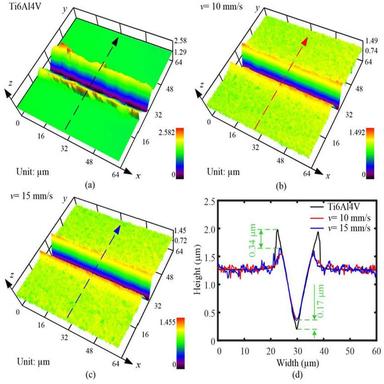
3D topographies of the residual scratches obtained on (a) the Ti6Al4V surface and the surfaces with nanoporous structures obtained under different laser scanning speeds (P = 1.48 W, r = 76.6 %, f = 700 kHz): (b) v = 10 mm/s and (c) v = 15 mm/s. (d) Profiles of the cross-sections marked in Fig. 12(a)-(c). The scratch load is kept to 100 mN.